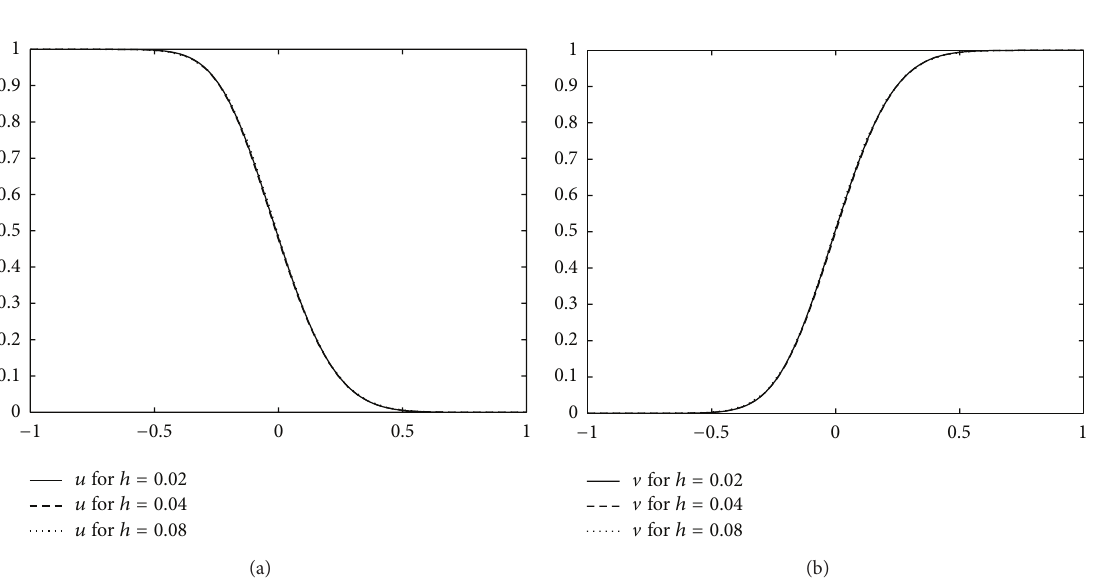
show them in Figure 4: 𝑀 (a) and 𝑀 (b). Considering u v the same numerical example we demonstrate convergence in Figure 5 where numerical solutions for different steps ℎ = .008 , ℎ = .004 , and ℎ = .002 are very close to each